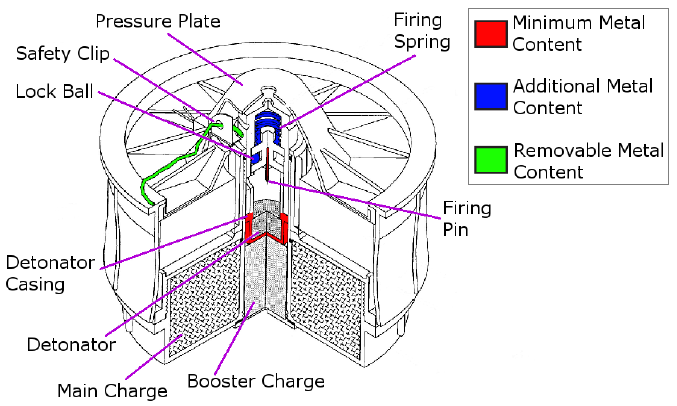
Figure 1. Metallic components present in minimum-metal anti-personnel mines. Adapted from